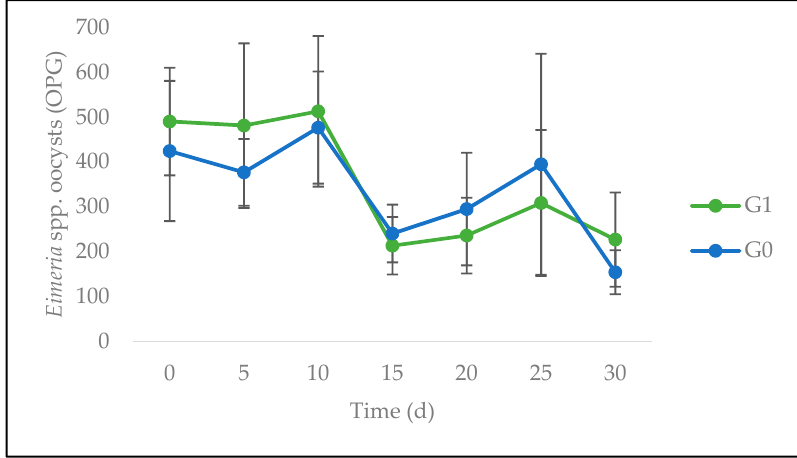
Figure 5. Evolution of Eimeria spp. oocysts per gram of feces (OPG) of sheep fed on C. nlemfuensis hay alone (G0) or G. ulmifolia foliage and C. nlemfuensis hay (G1) spp. d: day.